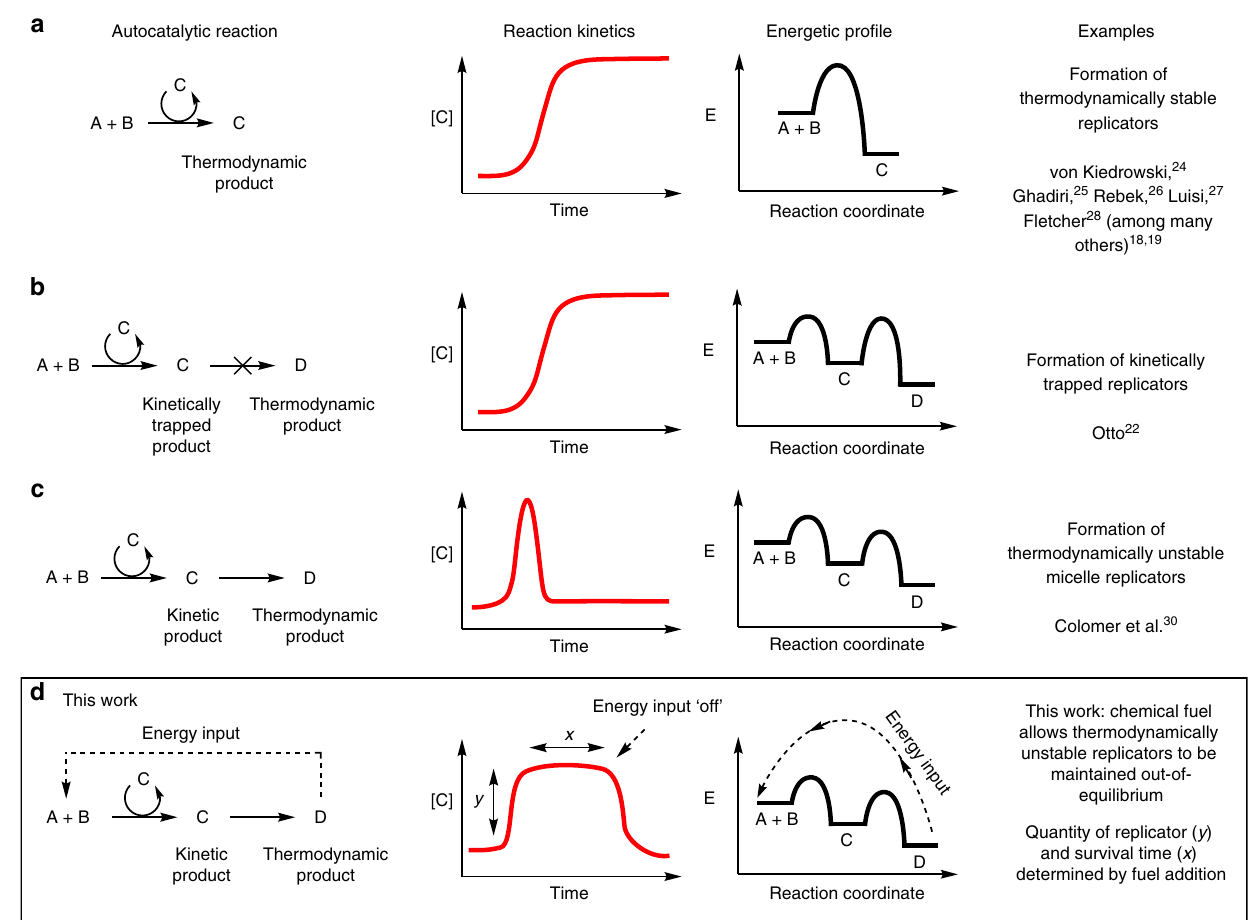
Fig. 1 The dynamics of some known self-replicators. a Autocatalyst C , or self-replicator C , is a catalyst for its own formation and is thermodynamically stable. b Self-replicator C promotes its own formation from a dynamic library of building blocks and products via supramolecular interactions, forming a kinetically trapped set of replicators 22 . c Self-replicator C is a catalyst for its own formation and is the kinetic product of the reaction. It is eventually destroyed to give thermodynamic, non-replicating, product D 30 . d This work: A replicator C that is both formed and destroyed can be maintained, out-of- equilibrium, by a chemical fuel. The quantity of replicator ( y ) and survival time ( x ) are determined by the addition of